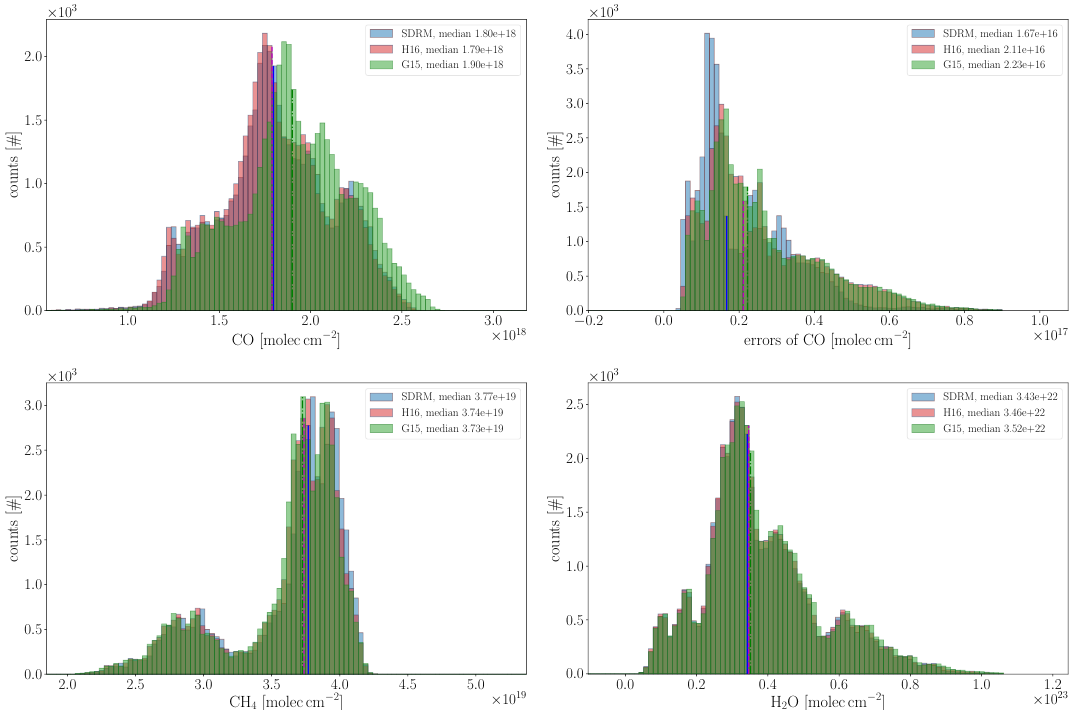
Figure 11. Distribution of retrieved quantities for Sahara. The CO columns and corresponding errors for different spectroscopic inputs and models are shown in the top-row. Histograms for the co-retrieved CH 4 and H 2 O columns are depicted in the two panels below. The median of each distribution is shown in the corresponding color.